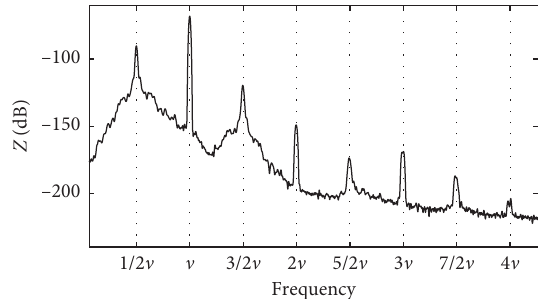
Figure 12: Power spectral density of the harmonic response, b